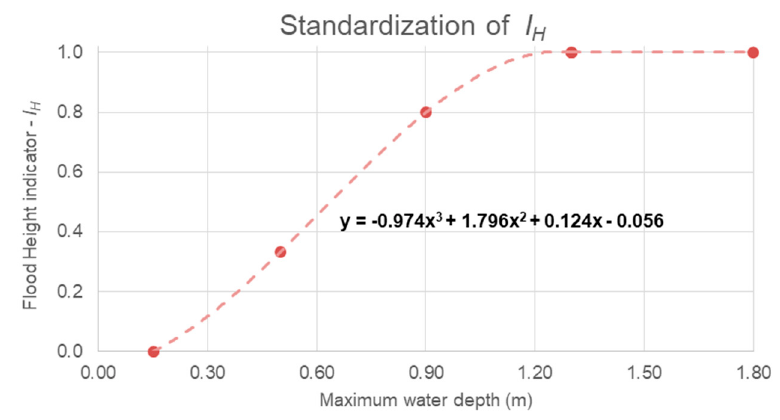
Figure 3. Standardization of the Flood Height indicator (I h ).